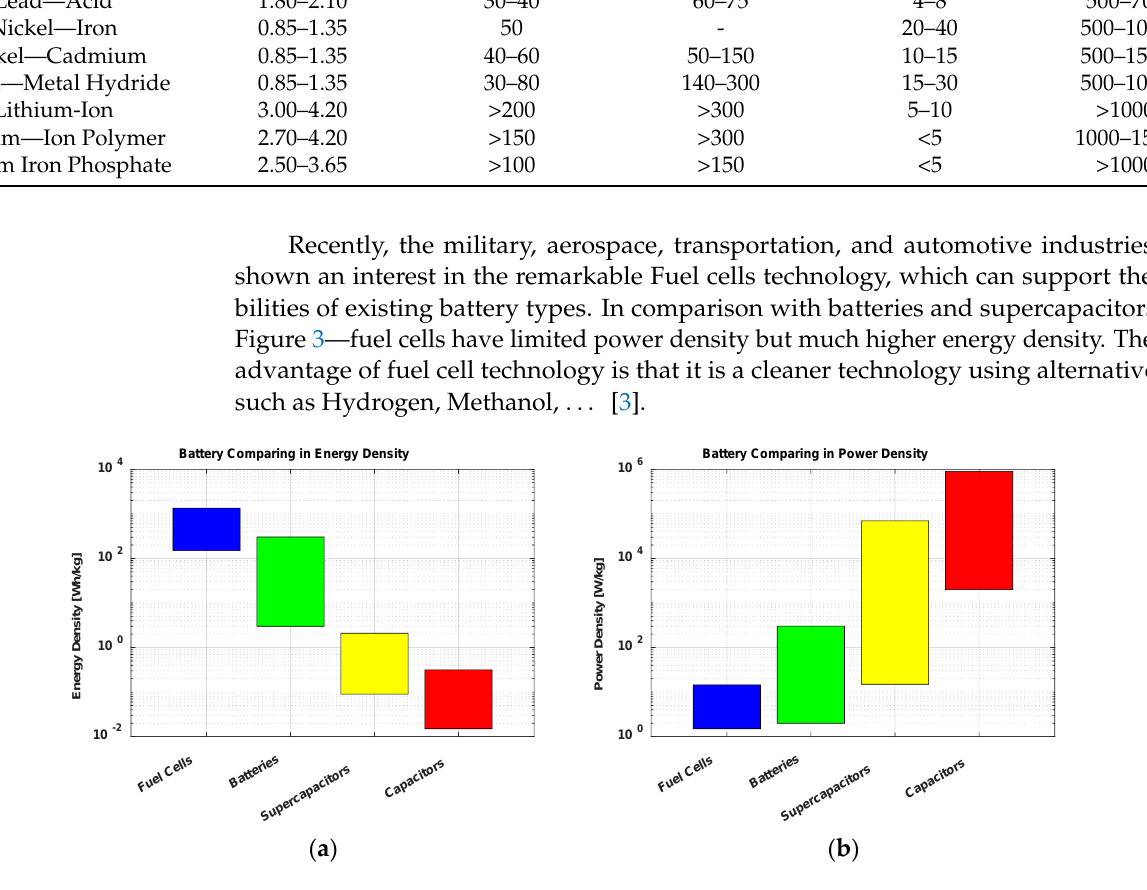
Figure 3. Battery power source comparison: ( a ) in energy density; ( b ) in power density [3,7,23,26].